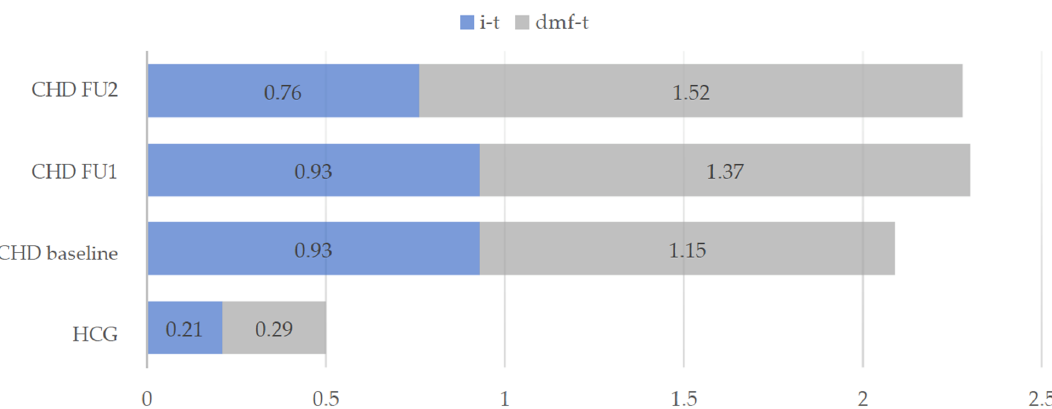
Figure 1. Mean dmf-t values and initial carious teeth (i-t) in the intervention group (CHD) and healthy control group (HCG) at baseline and during the two follow-ups (FU1 and FU2) of the CHD group.